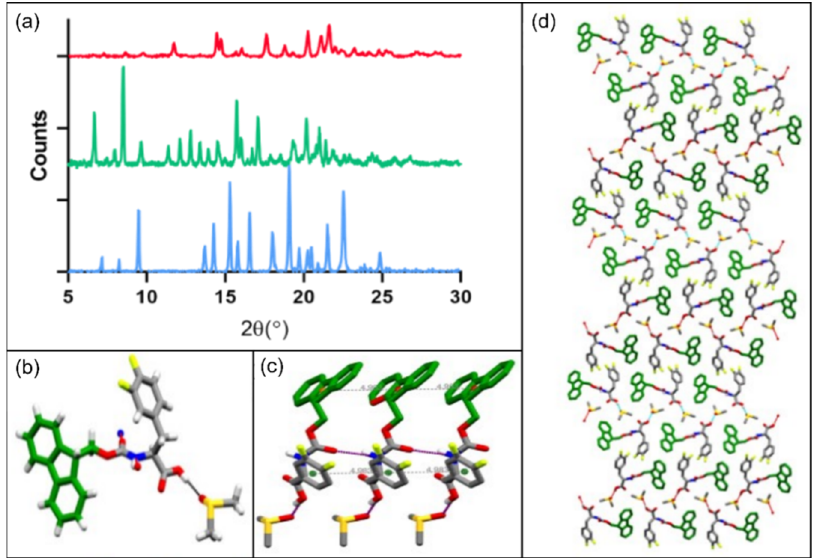
Figure 5. PXRD and Single crystal XRD structures. ( a ) PXRD of Fmoc-Phe (red) and the double fluorinated Fmoc-Phe building blocks; Fmoc-3,4F-Phe (blue), and Fmoc-3,5F-Phe (green). ( b ) Single crystal XRD structure of Fmoc-3,4F-Phe, demonstrating the asymmetric unit. ( c ) Intermolecular backbone hydrogen bonding and π – π stacking of the Fmoc-3,4F-Phe molecule, with a distance between two centroids of 4.983 Å. ( d ) Fmoc-3,4F-Phe crystal packing along the c-axis.